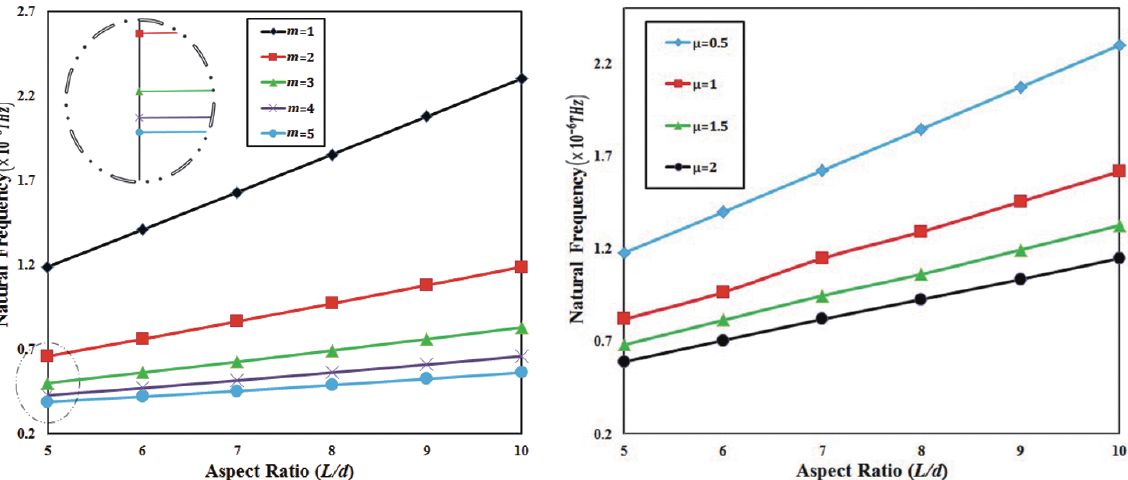
Fig. 3. Mode number effect on natural frequency of a short-SWCNT for different aspect ratio L/d and μ = 0 . 5 .